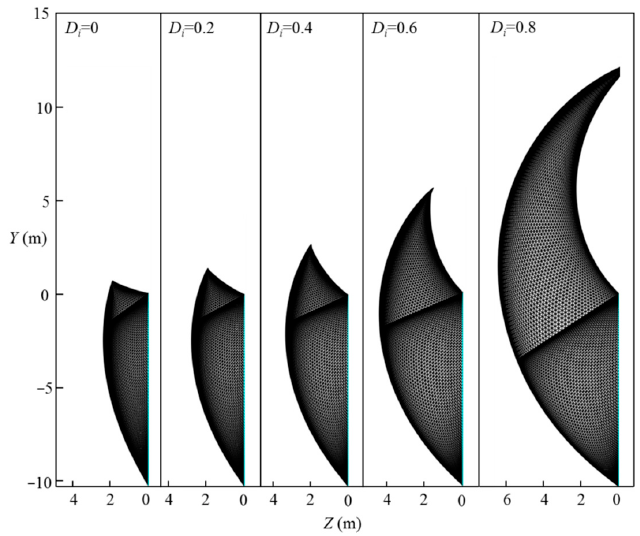
D on normalized limit support pressure, σ T / γ H. Figure 14. Effect of D i on normalized limit support pressure, σ T / γ H . i